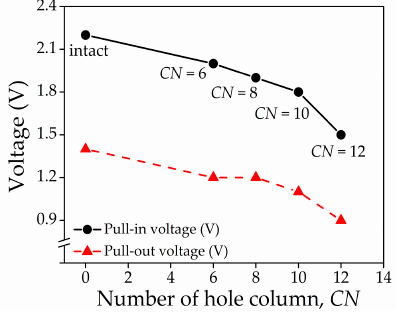
Figure 11. Comparison of actuation pull voltage characteristics between intact and perforated graphene-based NEM switch.